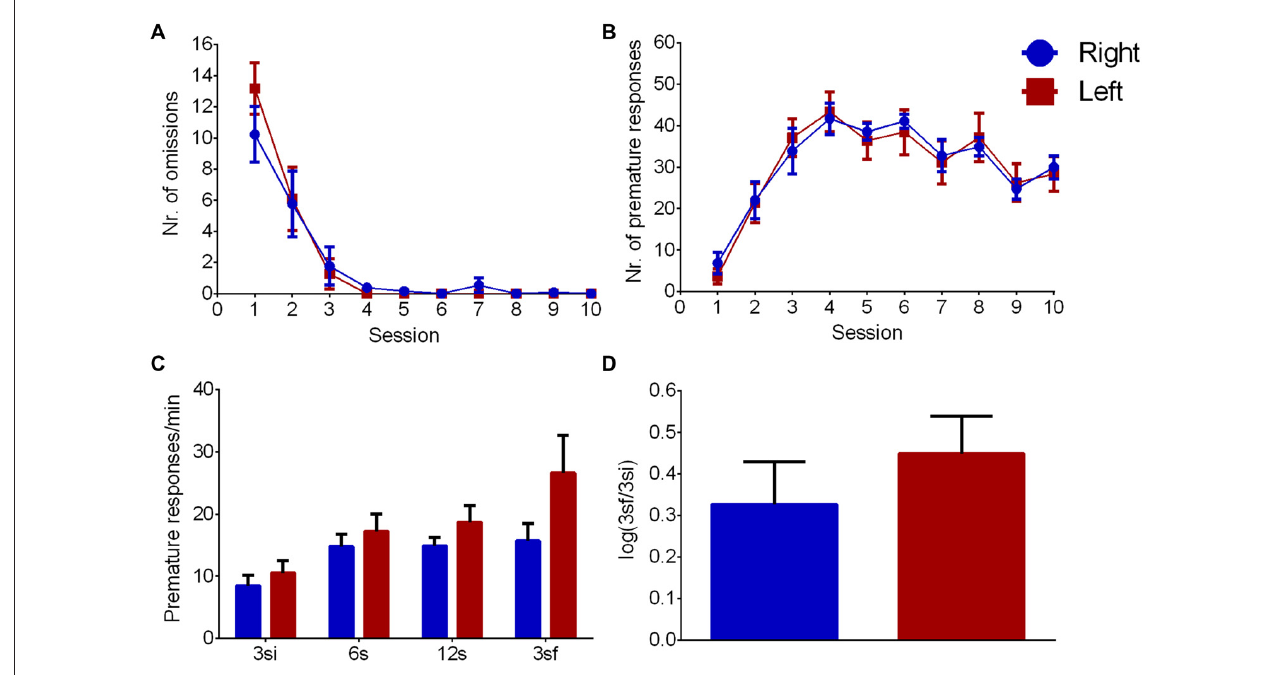
FIGURE 4 | Left/Right differences in impulsivity. Group comparison during VDS training (A,B) and test (C,D) . (A) Number of omissions, (B) number of premature responses, (C) premature responses per minute per interval and (D) logarithmic ratio of the number of premature responses in 3sf and 3si intervals. Data is shown as mean ± SEM. Blue—animals with right paw preference; Red—animals with left paw preference.